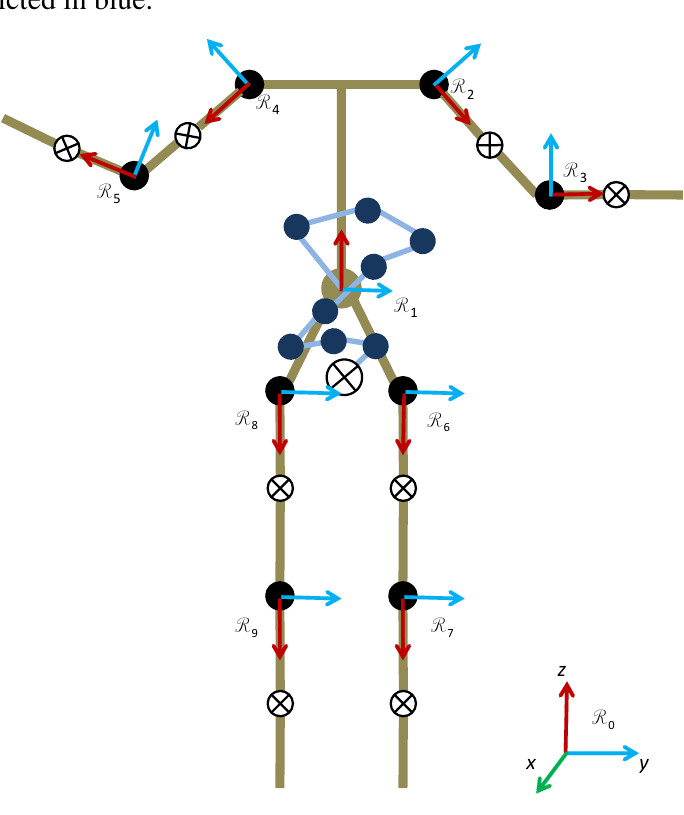
Figure 1. A human-like skeleton model made up of nine rigid body segments. The statically equivalent serial chain (SESC) representing the center of mass (CoM) position is attached to the torso and depicted in